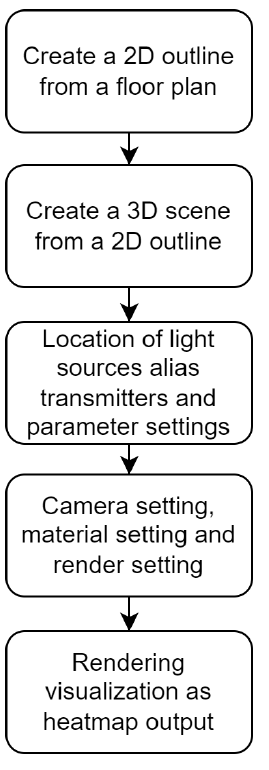
Figure 1. Procedure for creating heat